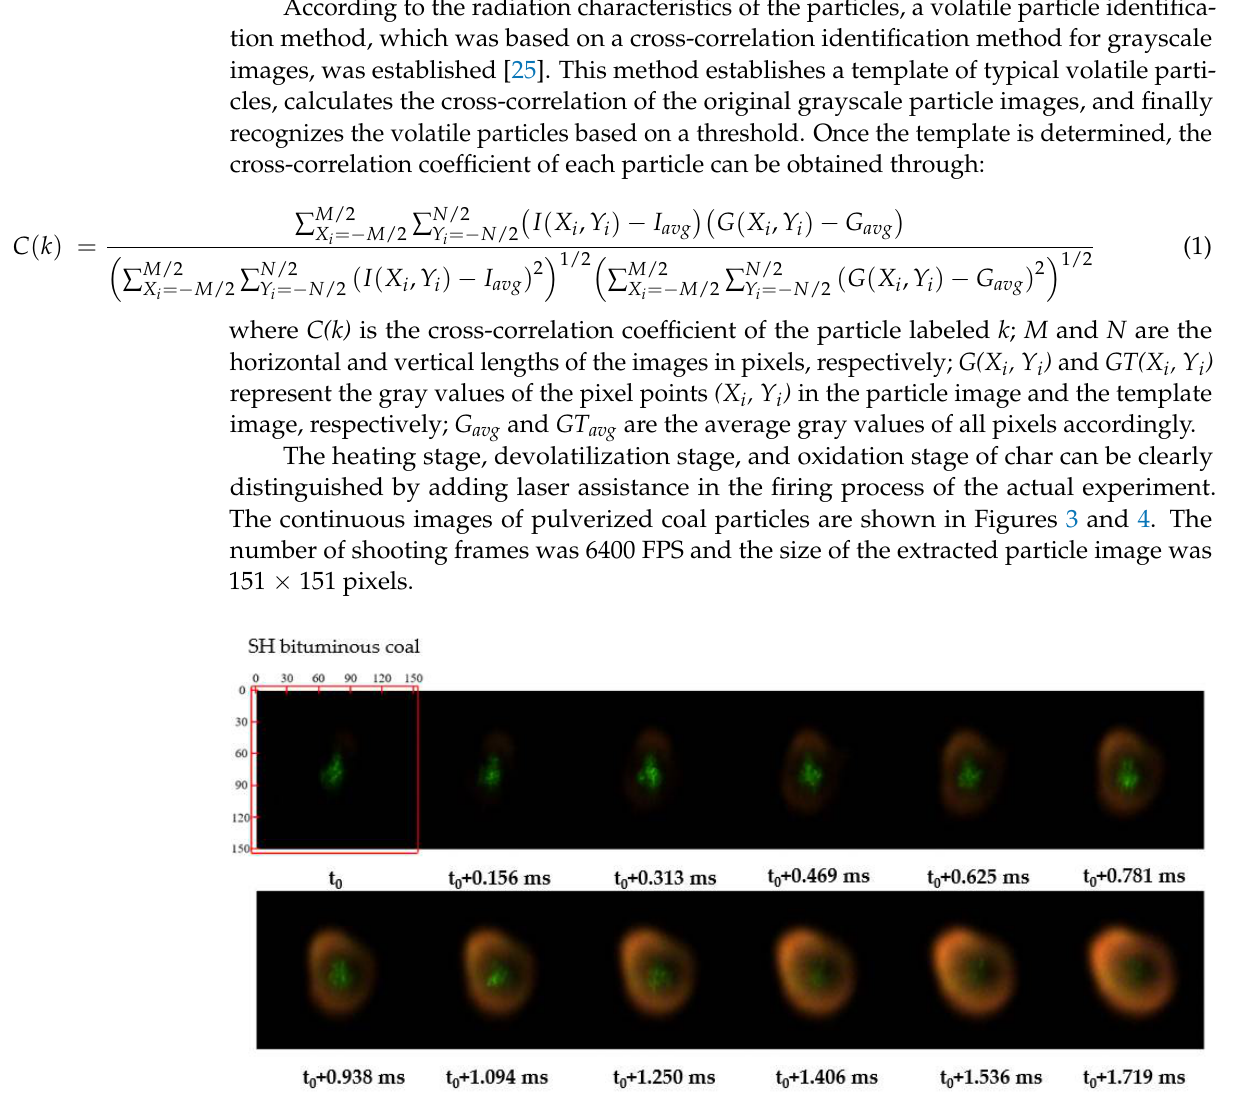
Figure 3. Continuous images of pulverized coal particles from the heating stage to the volatile burning stage.